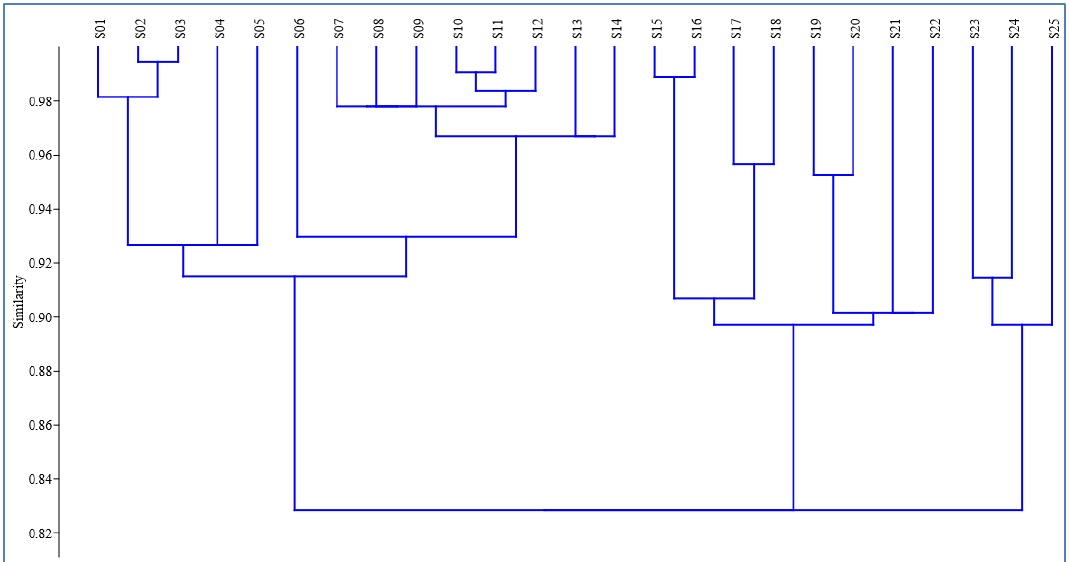
Figure 3. Dendrogram showing clustering of sampled groundwater.